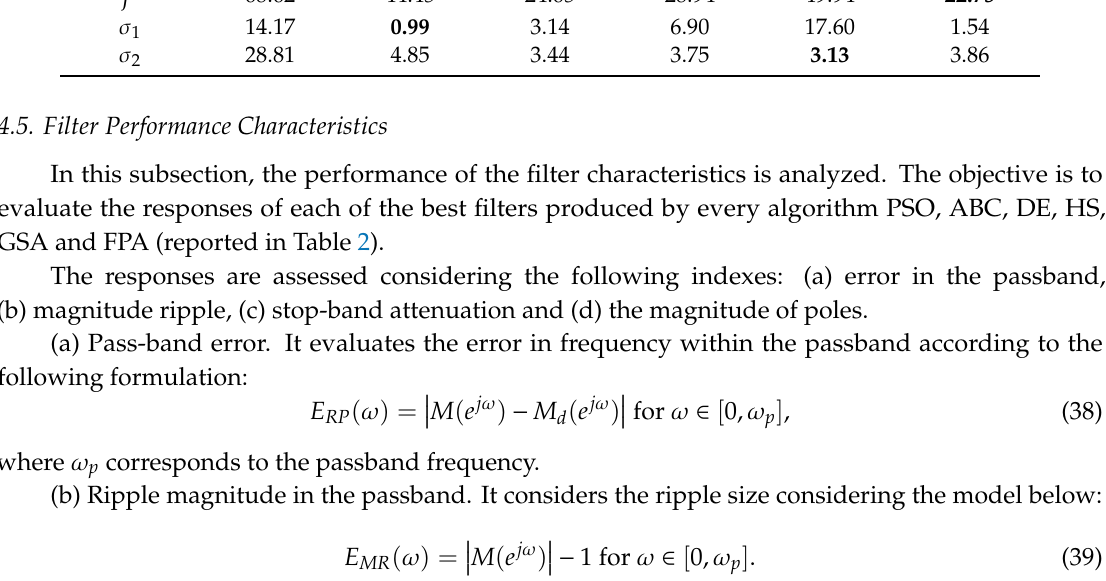
Table 4. Minimum ( J p ) and maximum ( J p max ) values of the objective function, mean ( J min deviation ( σ p ) for the results obtained by every case p = 1.2. PSO ABC